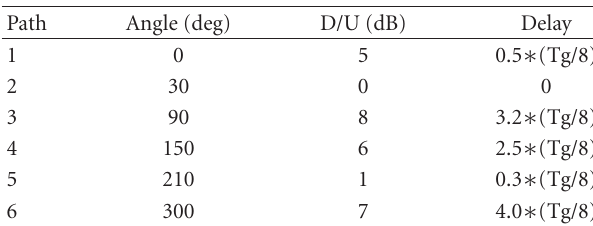
Figure 8: SPLINE time domain interpolator. Table 4: 6-path simulation parameters.